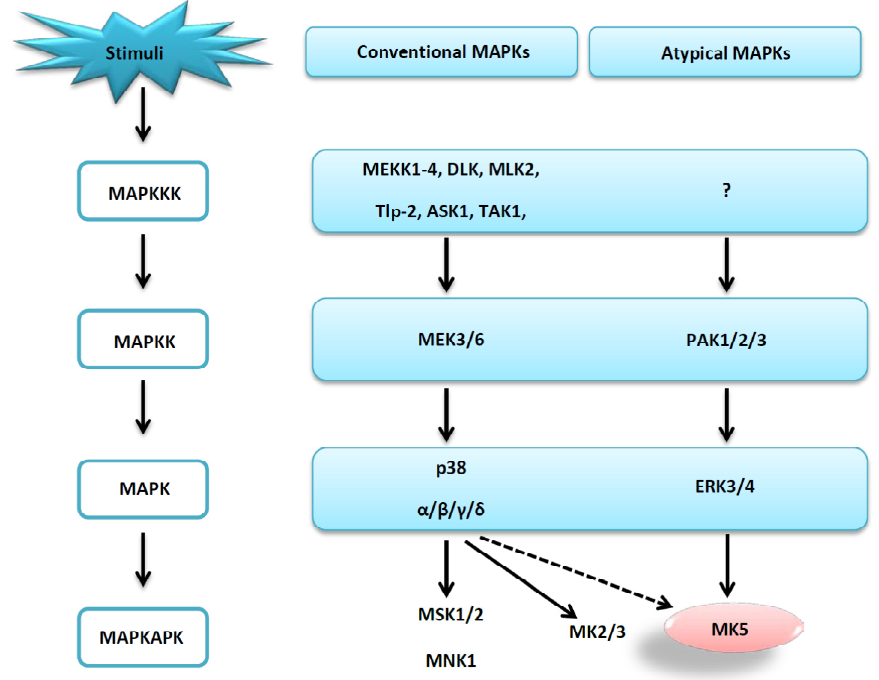
Figure 1. MAPK signalling cascades leading to MK5 activation. Mitogen-activated protein kinase kinase kinases 1-4 (MEKK1-4), the dual leucine zipper kinase (DLK), the mixed lineage kinase (MLK2), the mitogen-activated protein kinase kinase kinase 8 (Tpl-2), the apoptosis signal-regulating kinase 1 (ASK1), the transforming growth factor- β -activated protein kinase (TAK1) and the serine/threonine-protein kinase (TAO1/2) phosphorylates and activates dual specificity mitogen-activated protein kinase kinase3/6 (MEK3/6), which in turn phosphorylates and activates p38 α , β , δ and γ . p38 will then phosphorylate and activate mitogen- and stress-activated protein kinases 1/2 (MSK1/2), the MAPK-interacting kinase 1 (MNK1), MAPK-activated protein kinases 2/3 (MK2/3), and MAPK-activated protein kinase 5 (MK5). In addition to the p38 pathway MK5 can also be activated by extracellular signal-regulated kinases 3/4 (ERK3/4). ERK3/4 are activated by p21-activated kinases 1/2/3 (PAK 1/2/3). The kinase/kinases activating PAK is currently unknown. Dotted line indicates that although activation has been reported, it has to be thoroughly investigated, while solid lines indicate validated